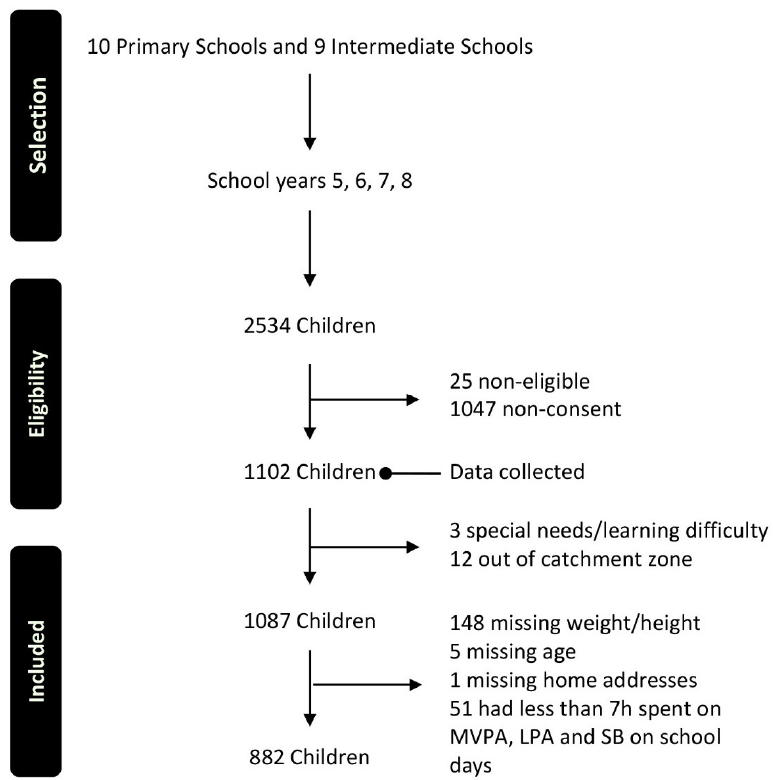
Figure 1. Flow of selection, eligibility checking, data cleansing, and study inclusion. Moderate-to- vigorous physical activity (MVPA); light-intensity physical activity (LPA); sedentary behaviour